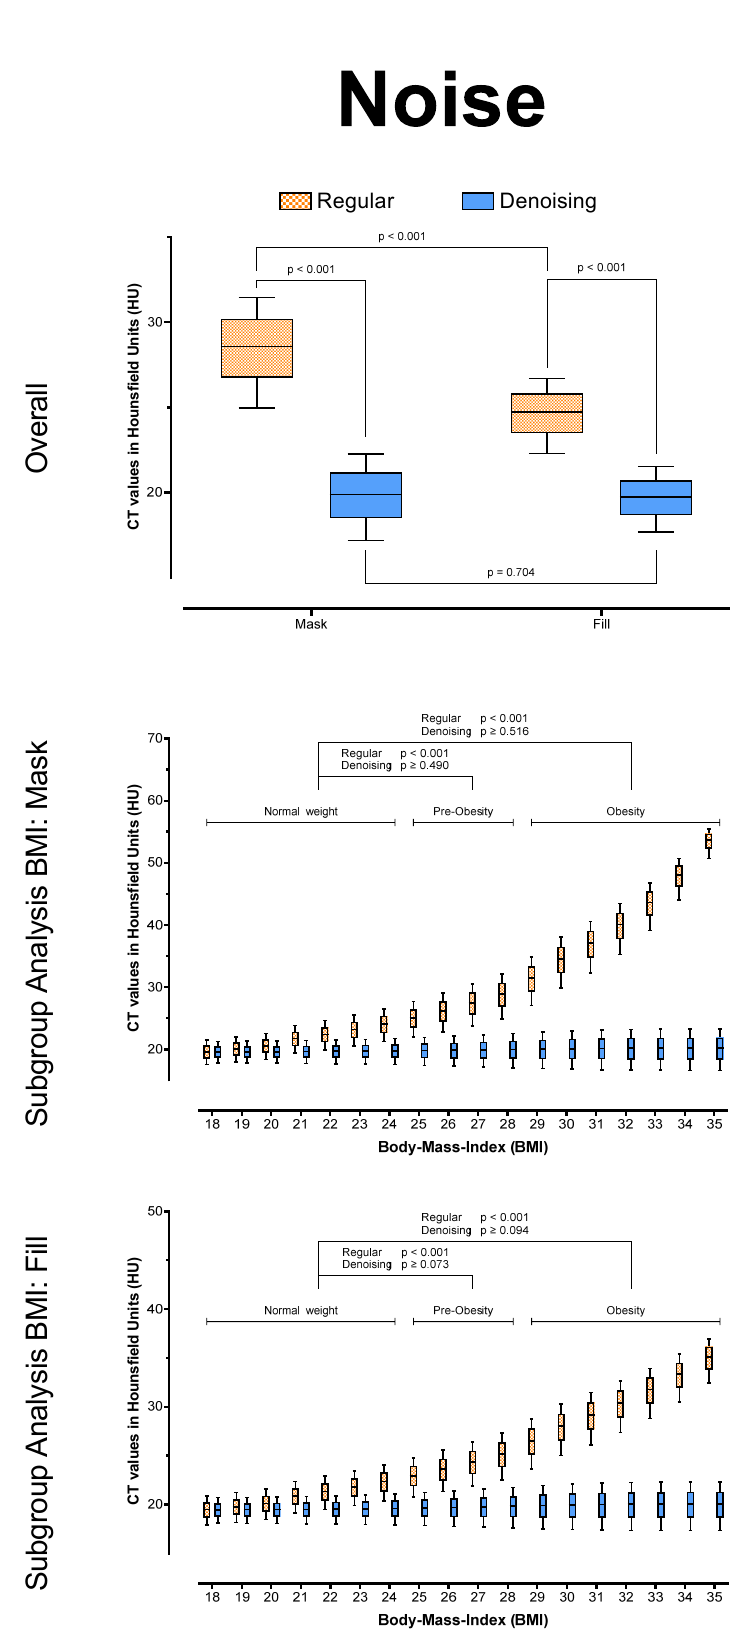
Figure 4. Noise (SD of HU), overall and posthoc subgroup analysis for patient BMI.